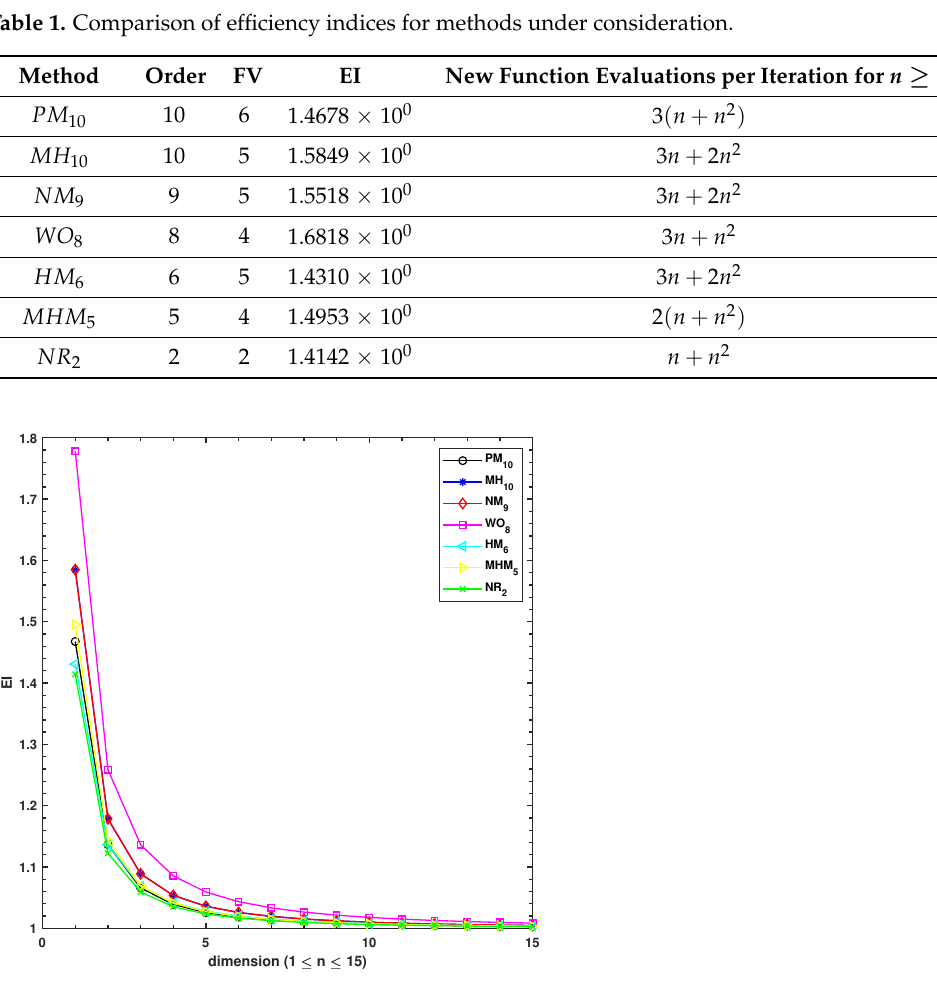
Figure 2. Behavior of efficiency index of various iterative methods for increasing dimensions of the nonlinear